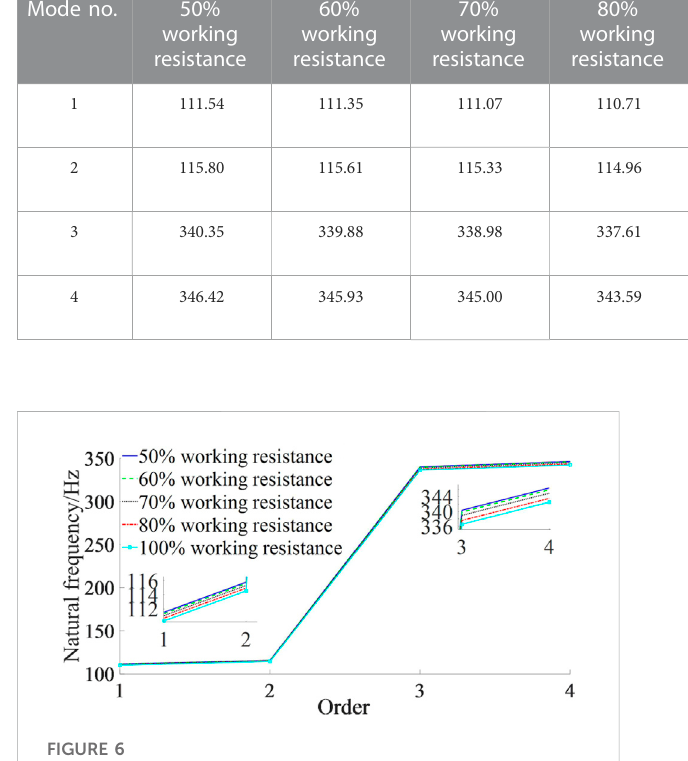
TABLE 4 Frequency and vibrational mode of the fi rst 4th-order of column at different setting forces. Mode no.